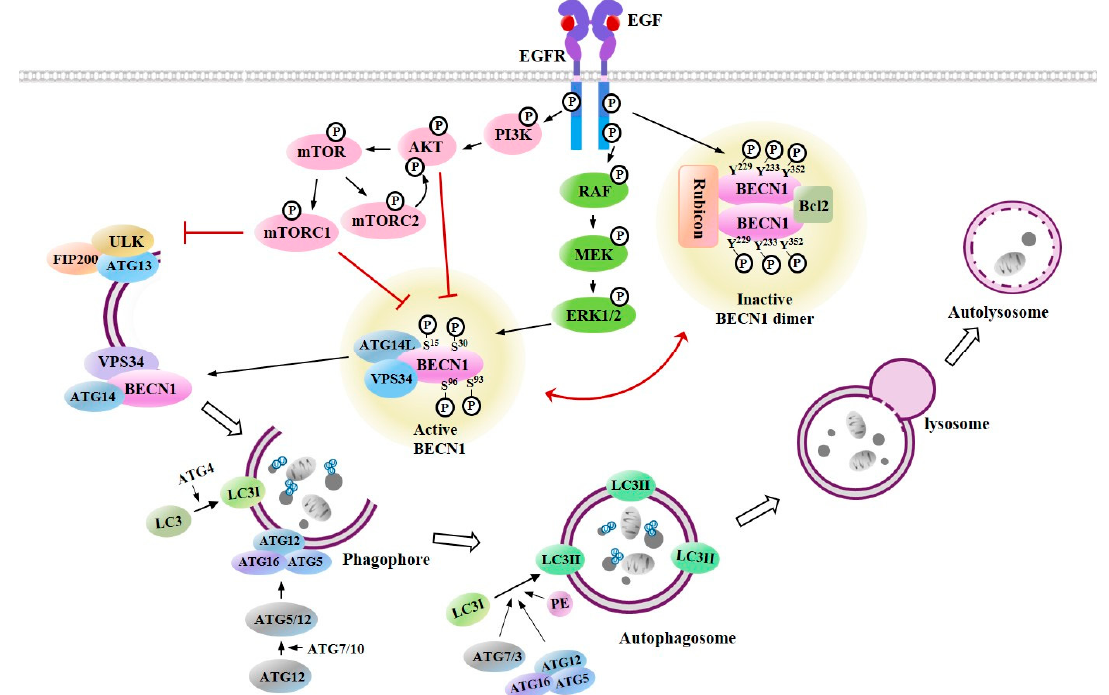
Figure 4. Cross talk between EGFR signaling and autophagy. Tyrosine phosphorylation of Beclin1 by EGFR leads to homodimerization of Beclin1 and binding of inhibitors of autophagy such as rubicon and B-cell lymphoma 2 (Bcl-2) to Beclin1 to decrease autophagic activity. EGFR-PI3K/AKT/mTOR signaling can inhibit autophagy by inhibiting phosphorylation of Beclin1 on serine residues. EGFR-RAF/MEK/ extracellular signal-regulated kinases (ERK) signaling can activate autophagy by increasing serine phosphorylation of Beclin1. Beclin1-containing class III PI3 kinase complex initiates formation of autophagosomes. Autophagophore formation requires ATG12-ATG5-ATG16L1 conjugate. ATG4 cleaves microtubule-associated protein 1-light chain 3 (LC3) at the C-terminus to result in formation of LC3I, which is conjugated with phosphatidyl ethanolamine (PE) to become LC3II. LC3II is present on autophagosomes. Autophagosome fuses with lysosome to form autolysosome where intracellular contents are degraded and are recycled.